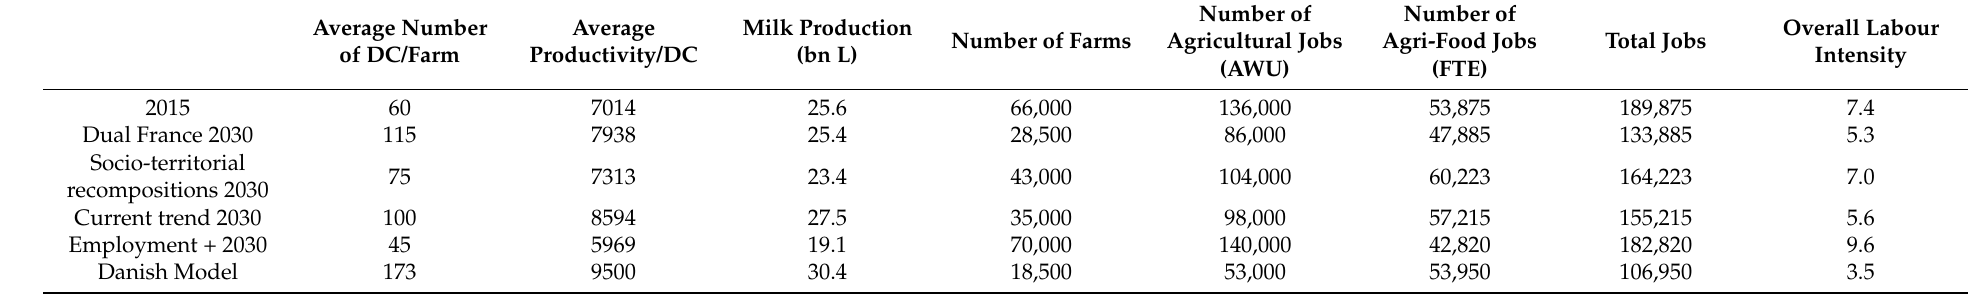
Table 3. Sensitivity of the model to alternative assumptions in terms of employment (Source: RICA & RGA (data 2015) and authors from IAA_Calc and SP_Calc for the